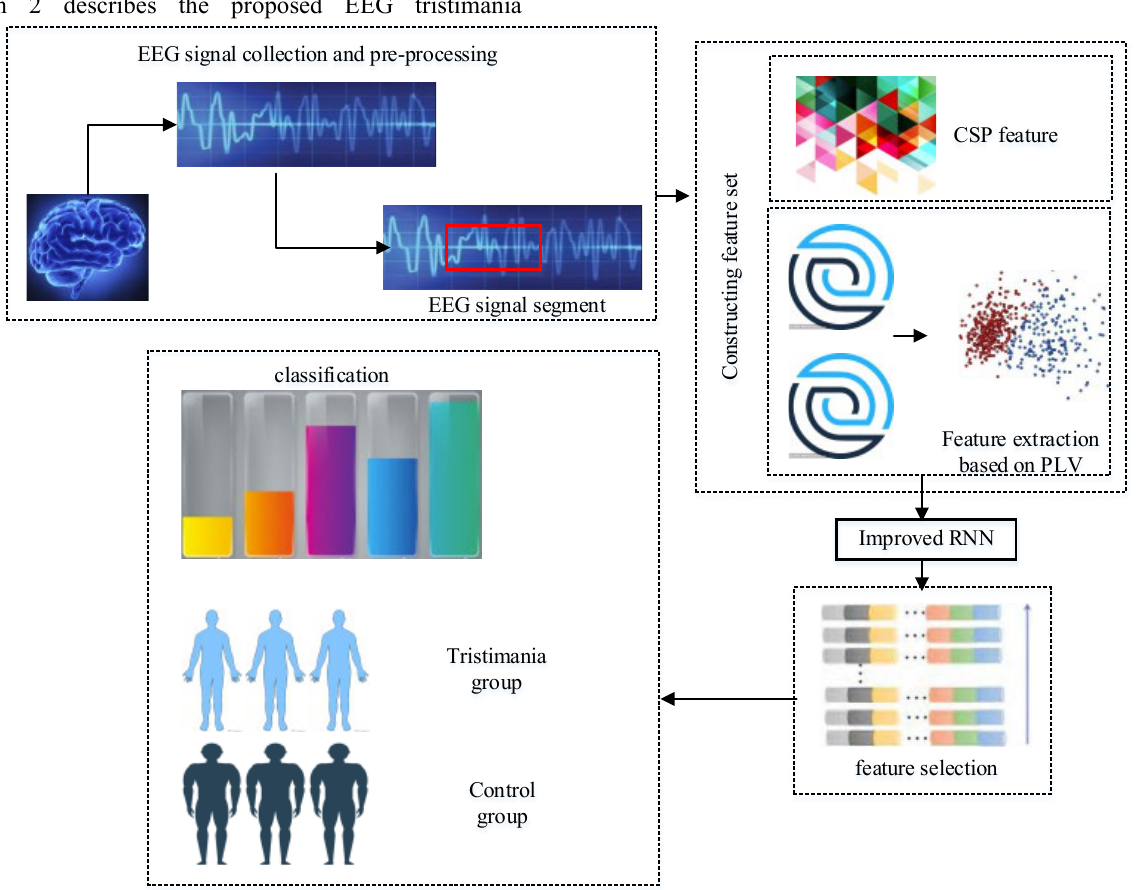
Figure 1. The framework of proposed